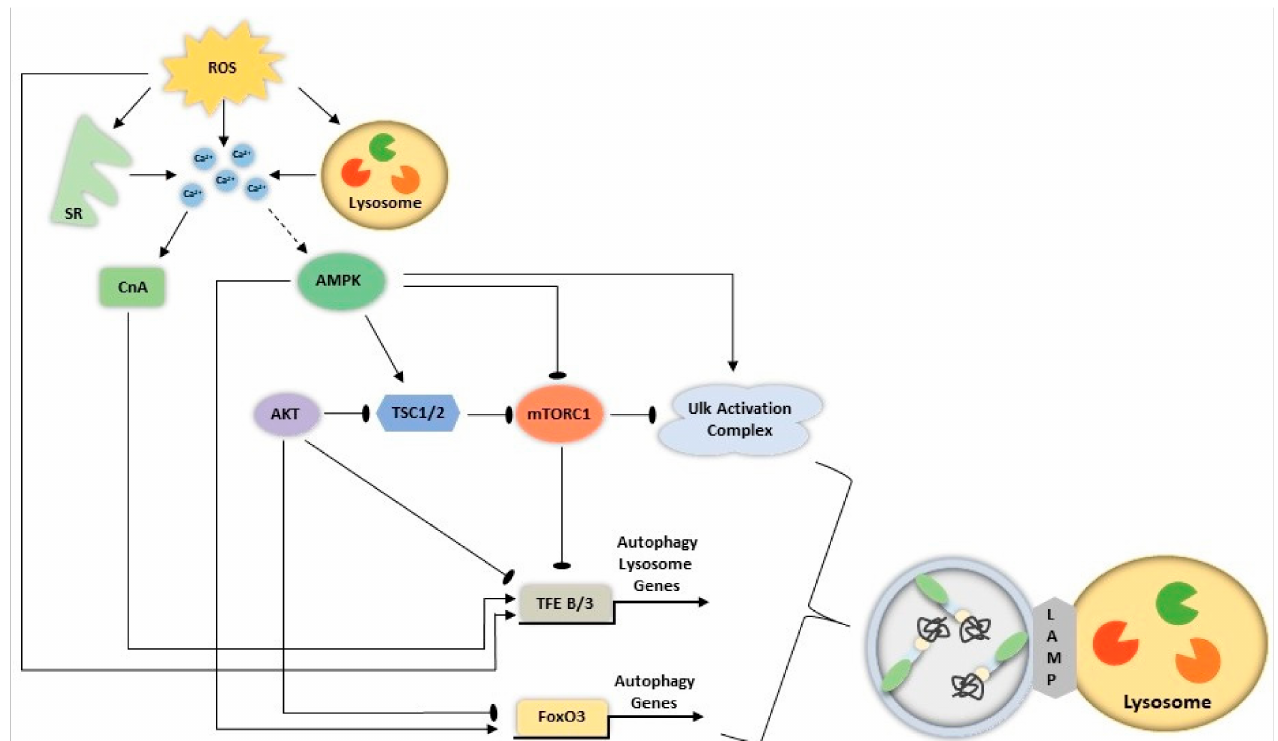
Figure 1. Proposed coordination of pathways that regulate the autophagy-lysosome System (ALS). ROS and cytosolic calcium ([Ca 2+ ] IC ) act as upstream signaling mechanisms that converge on the gene expression and protein activation of the ALS. AMPK is activated directly via compromised energy status (increase AMP:ADP), and indirectly through [Ca 2+ ] IC via CaMKII (not shown). Elevated [Ca 2+ ] IC may occur due to the damaging effects of elevated ROS, from mitochondria or other sources, on the sarcoplasmic reticulum and lysosomes. AMPK synchronously activates FoxO3, Tfeb and Tfe3 (Tfeb/3) through (1) direct phosphorylation of FoxO3, (2) activation of TSC1/2 and (3) inhibition of mTORC1. Simultaneously, AMPK activates autophagy induction through the Ulk1 complex and by alleviating mTORC1 inhibition on this complex. In a similar cellular milieu, FoxO3 repression is alleviated via AKT inhibition. Increases in [Ca 2+ ] IC activate the phosphatase CnA, which activates Tfeb/3. ROS also activate Tfeb/3 through oxidation, an added layer of coordination in this autophagy-lysosome